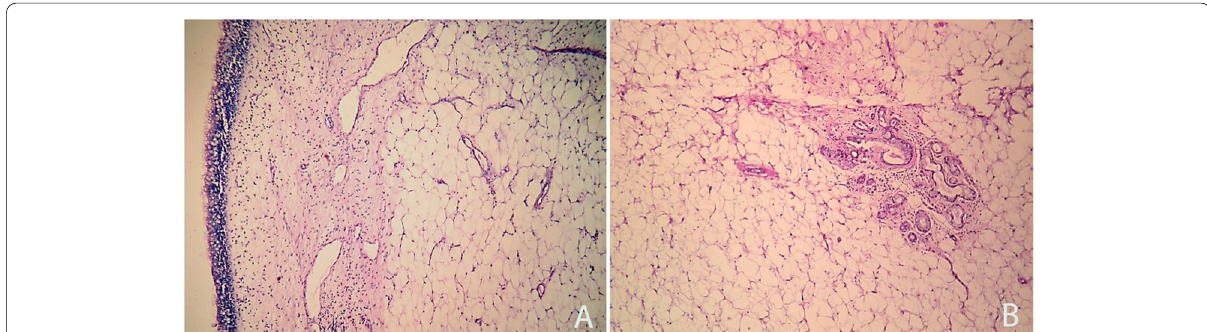
Fig. 4 A Microscopic pictures of the received specimen reveals a fragment focally lined by pseudostratified ciliated columnar epithelium resting on a fibrous layer of variable thickness with mild inflammatory infiltrate. B Higher magnification showing the underlying tissue composed of well‑circumscribed benign growth composed of mature adipocytes with intervening fibrovascular septae. Seromucous (salivary gland type) glands arranged in a lobule with surrounding delicate fibrosis and inflammatory infiltrates is seen at the periphery of the lesion. Pictures suggestive of